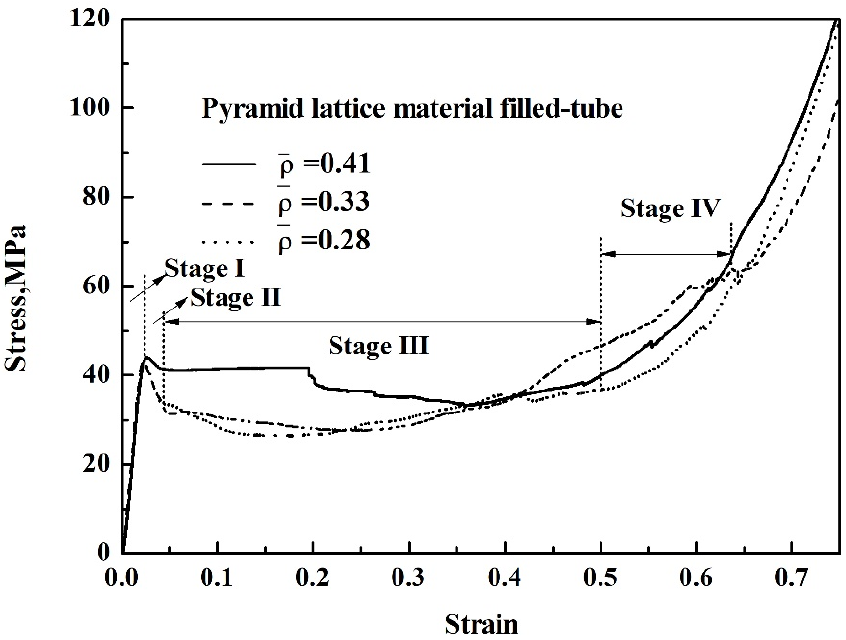
Figure 5. Stress–strain curves of the pyramid lattice material-filled tube with different relative densities.